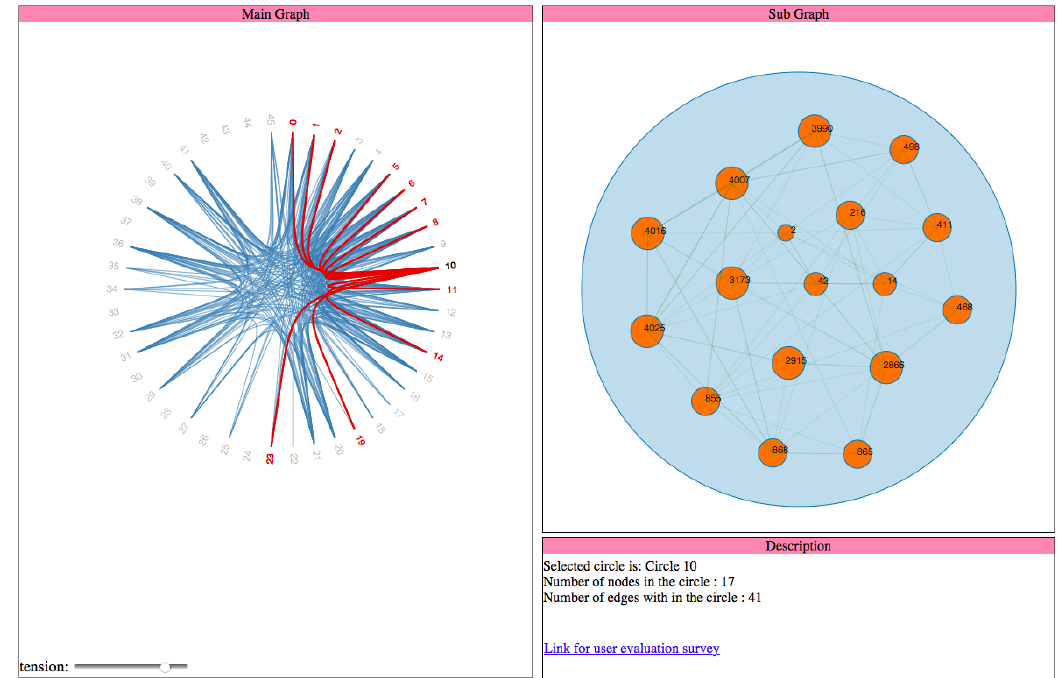
Figure 8. User interface for visualization using hierarchical edge bundling for the main graph and circle packing for the sub graph.